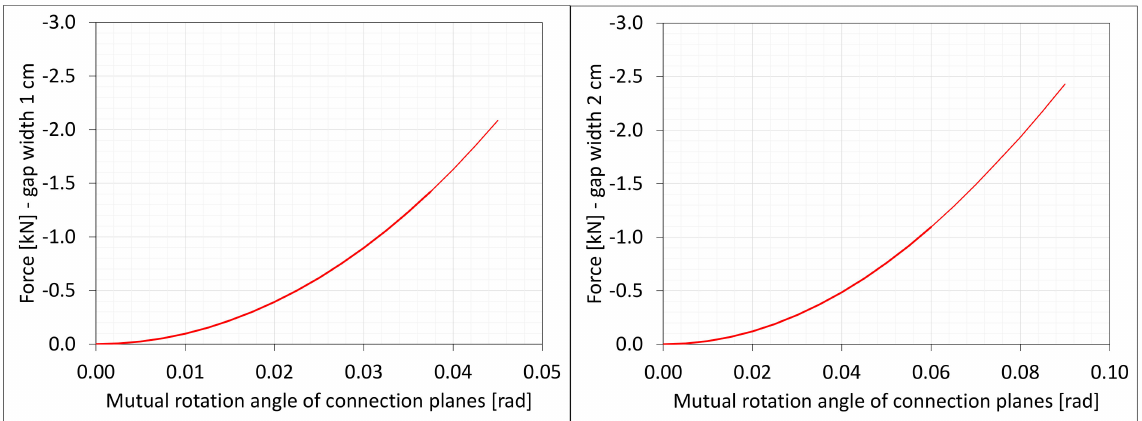
Figure 11. Equilibrium paths for excitation force N z . The width of the gap is equal to 1.0 cm, left graphic, and 2.0 cm, right graphic. Parts of charts with non-physical deformations are displayed with thin